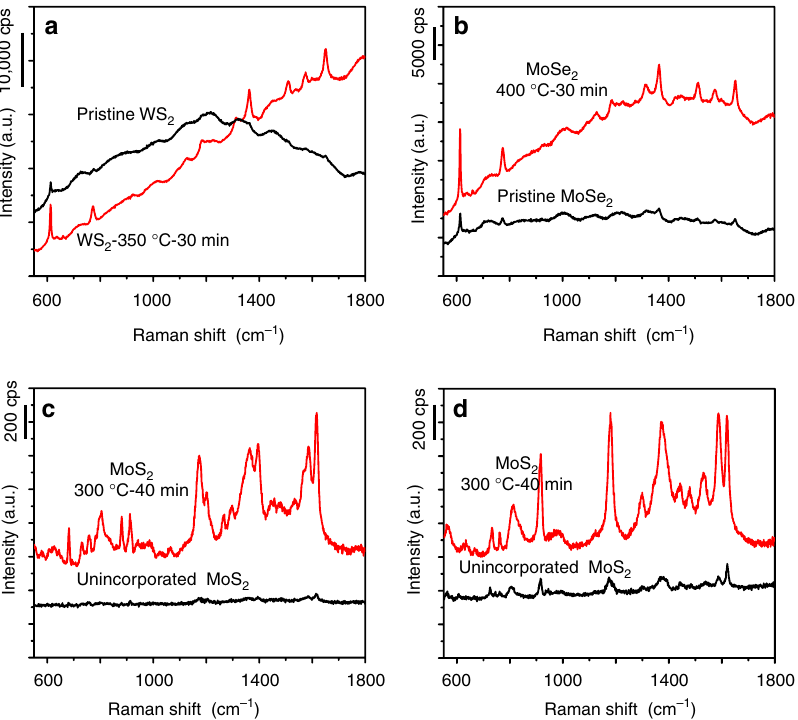
Fig. 5 The universality of oxygen incorporation approach. The approach can be extended to other materials for a series of probe molecules. SERS spectra of R6G on a series of other semiconductor materials a WS 2 and b MoSe 2 . SERS spectra of Victoria blue B c and crystal violet d on the partially oxidized MoS 2 sample at 300 °C for 40 min and unincorporated MoS 2 ,